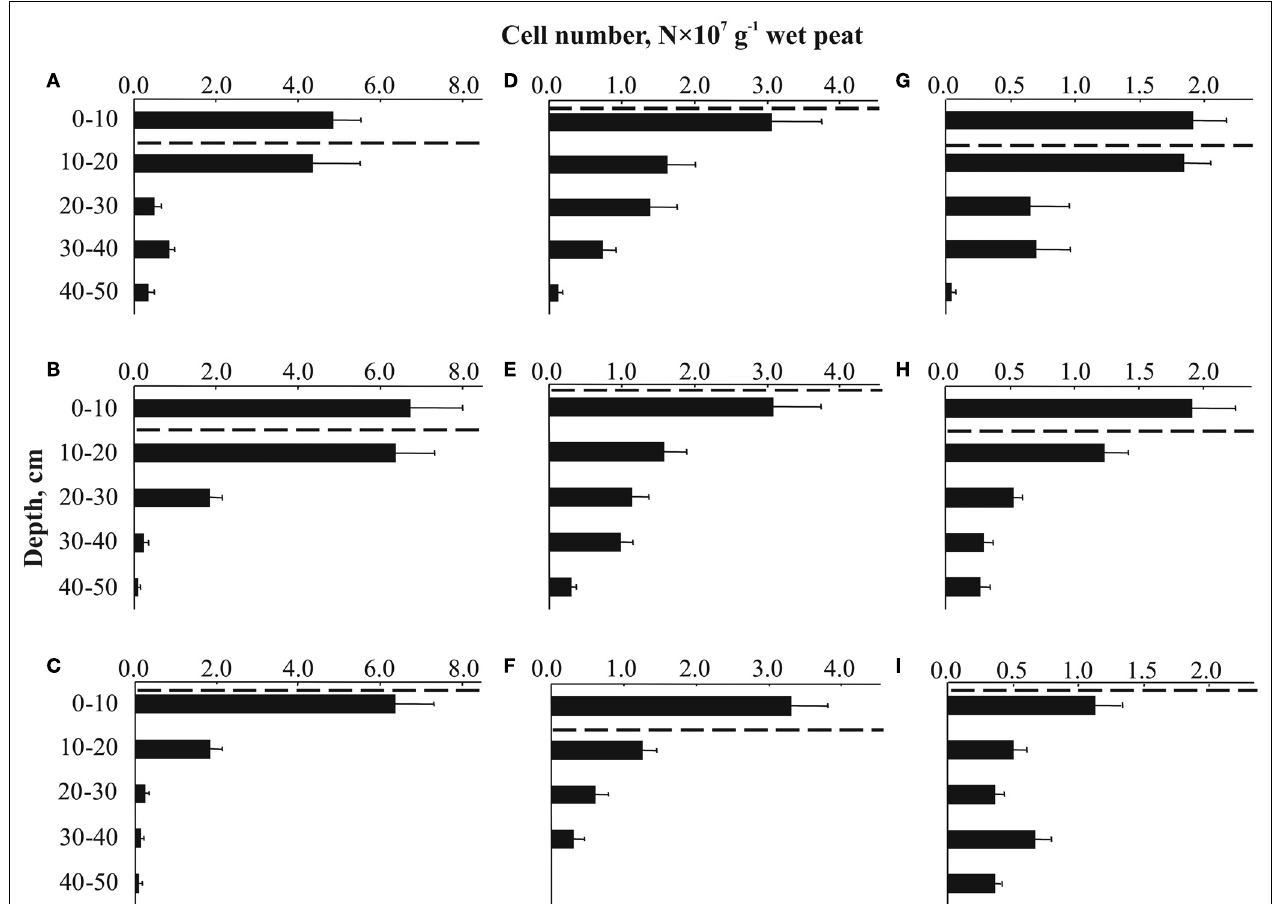
Muksalma (Archangelsk region); (G)Torfjanoye (Archangelsk region); (H) Valdayskoye (Novgorod region); (I) Bakchar (West Siberia,Tomsk region). The dashed line indicates the water table level during the sampling.Values are means from 100 randomly chosen counting fields of view; error bars indicate